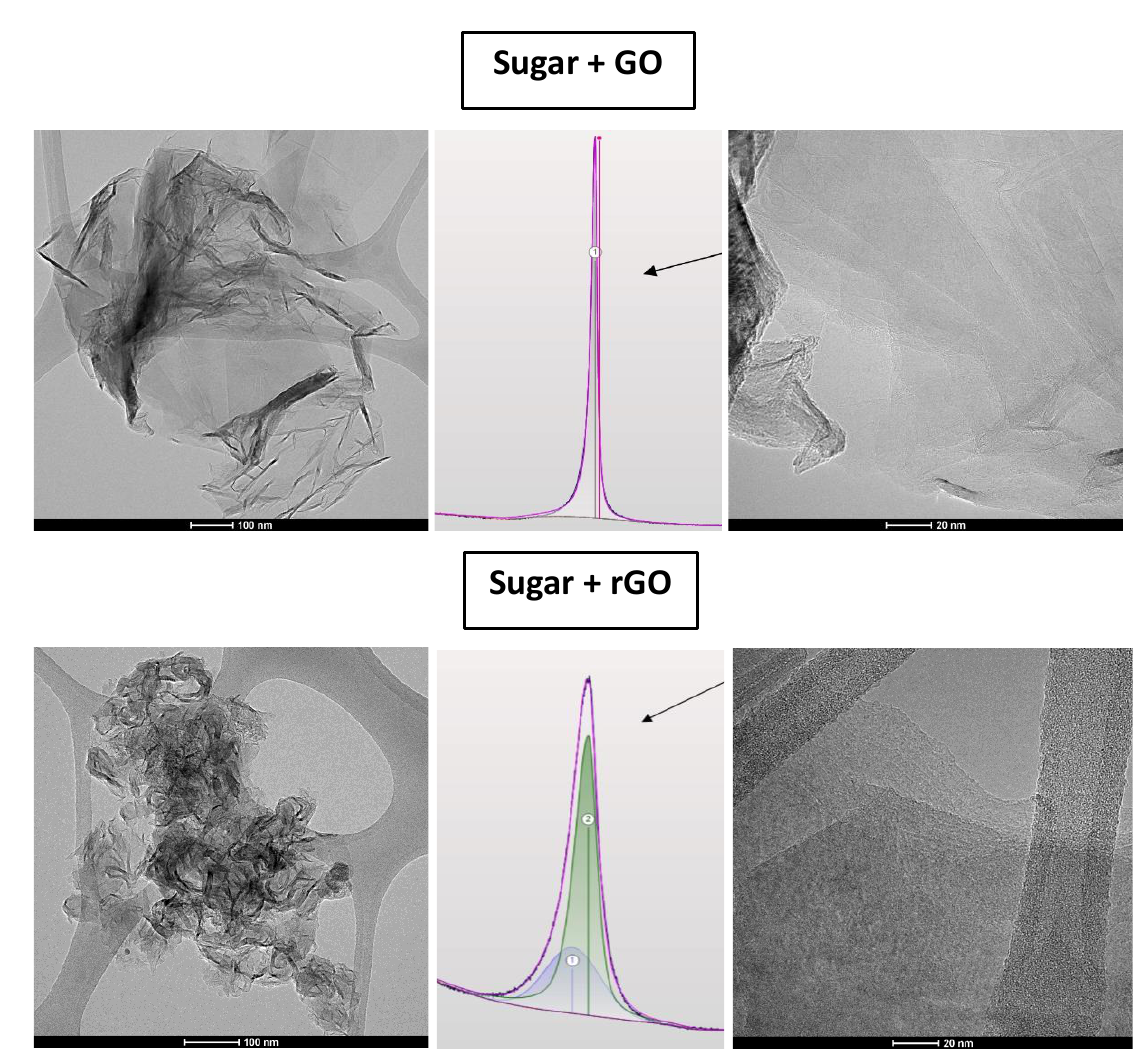
Figure 4. HRTEM images for C-C composites fabricated from the indicated precursors. Center panels show the XRD d 002 peaks for each, illustrating the single or two components for the two composites.